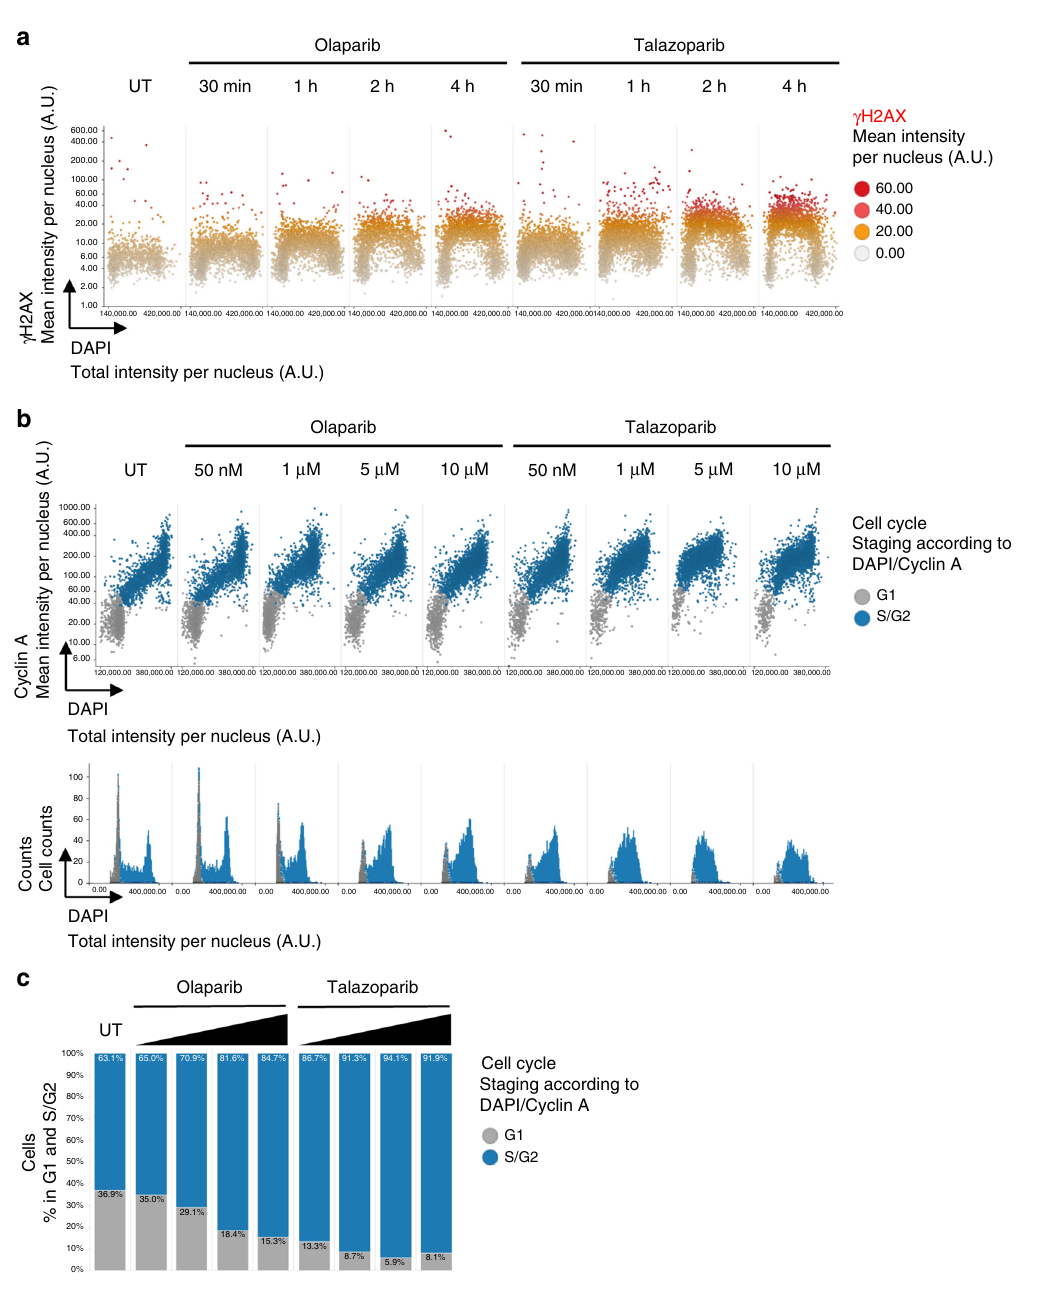
Fig. 5 PARPi-induced cell cycle arrest revealed by quantitative imaging. a U-2 OS cells were treated with PARPi olaparib or talazoparib (both 10 μ M) as indicated and stained for γ H2AX and DNA content. Cell cycle resolved γ H2AX pro fi les are shown. b Cells were treated for 24 h with different concentrations of PARPi olaparib or talazoparib as indicated and stained for Cyclin A and DAPI. Two-dimensional cell cycle pro fi les based on Cyclin A and DAPI intensities per nucleus are shown. One-dimensional cell cycle pro fi les are shown below. c Percentages of cells in G1 and S/G2 respectively. Color codes as de fi ned in the fi gure